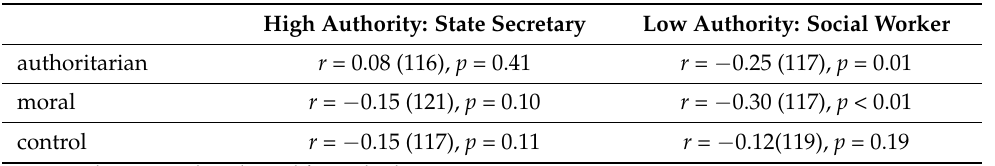
Table 2. Spearman correlations between trait autonomy and absolute pre-post difference across all seven items for the 3 × 2 treatment